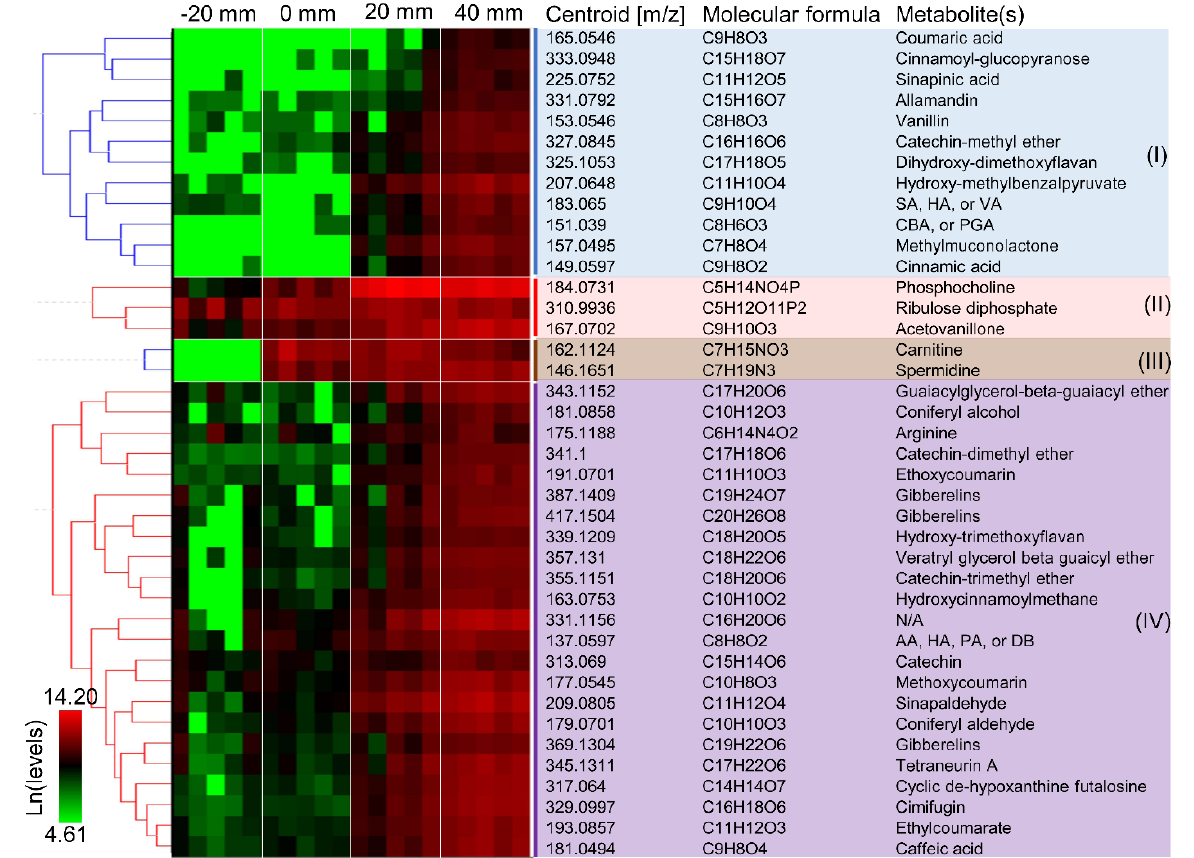
Figure 2. Clustering of discriminate metabolites according to their temporal functions during brown rot. Forty metabolites are shown with their m/z ions, molecular formula, and tentative identity. The labels − 20, 0, 20, and 40 mm represent non-decayed, early, mid-decay, and late decay stages, respectively. Intensity values of five bioreplicates of metabolites were used for hierarchical clustering with HCE3.5 after ln transformation.